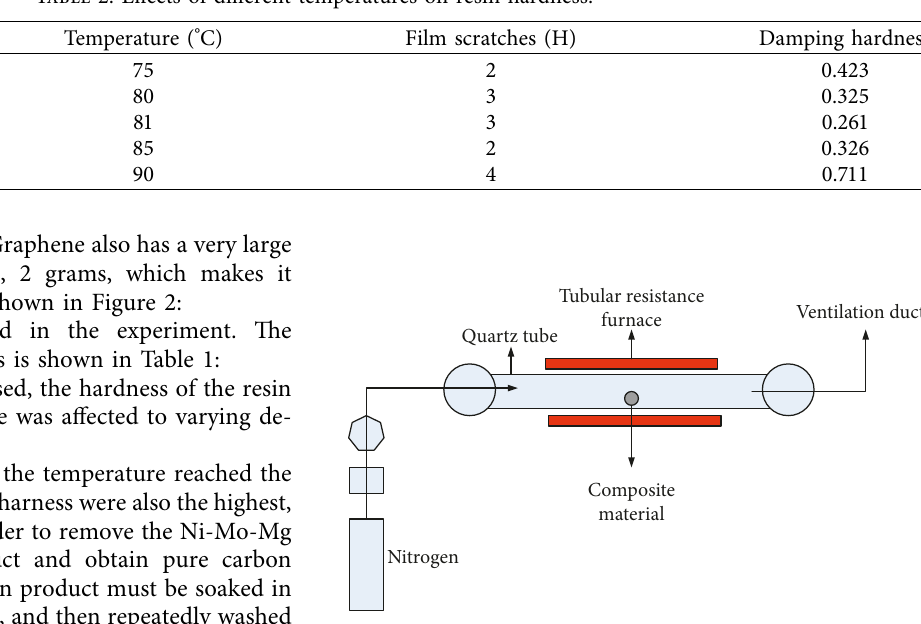
Figure 3: Schematic diagram of combustion experiment.